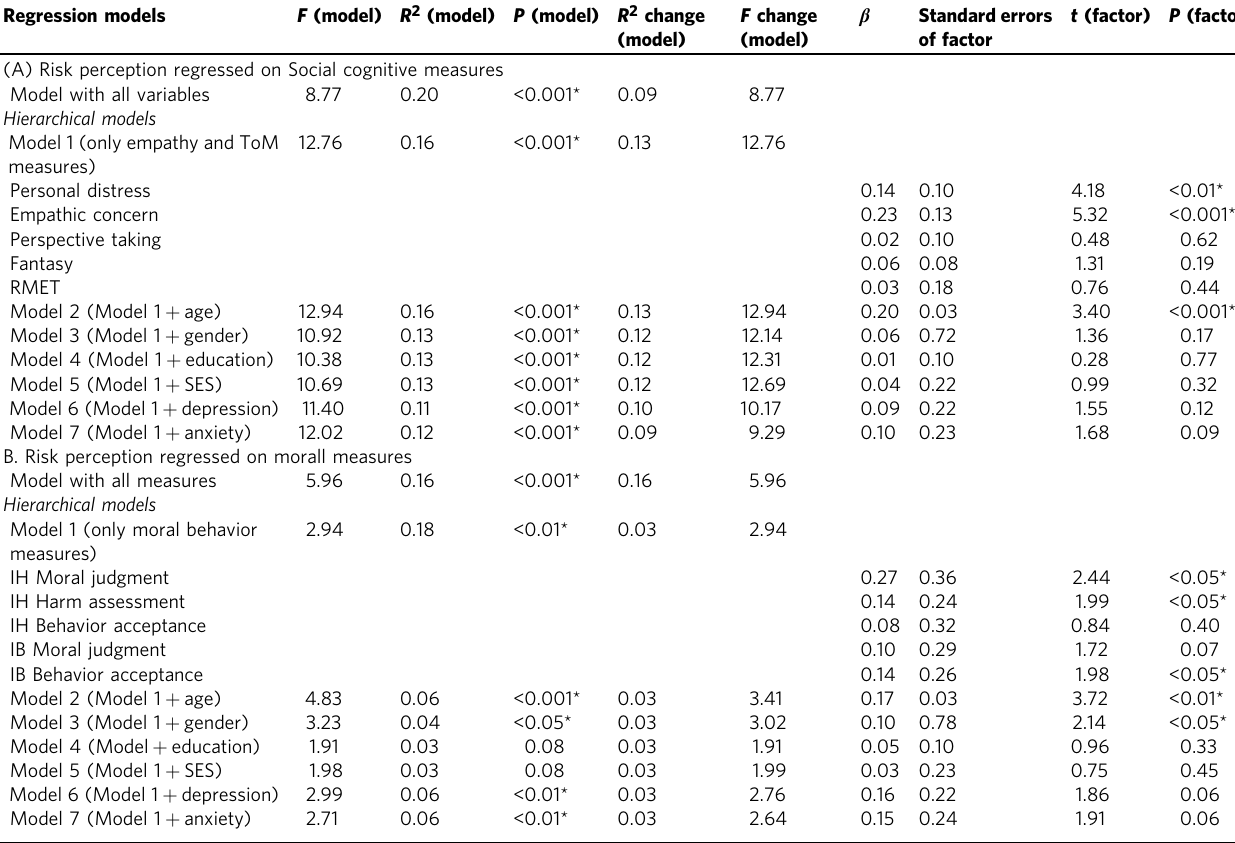
Table 2 Regression models of risk perception.